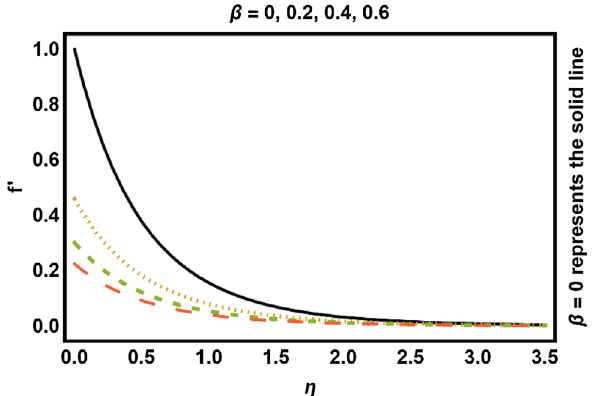
Figure 4. Slip effects on velocity field.